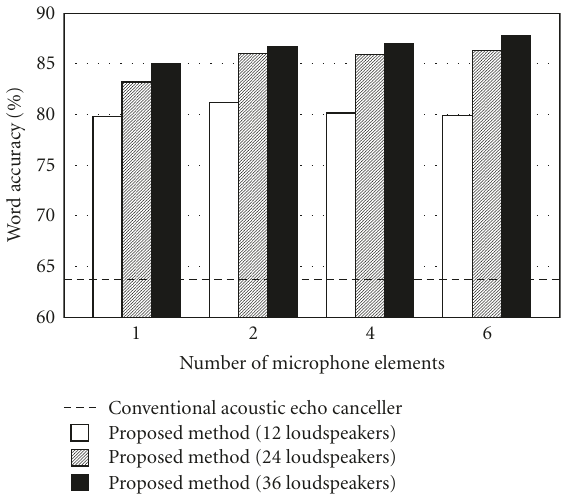
Figure 13: Layout of the experimental room in the sound quality